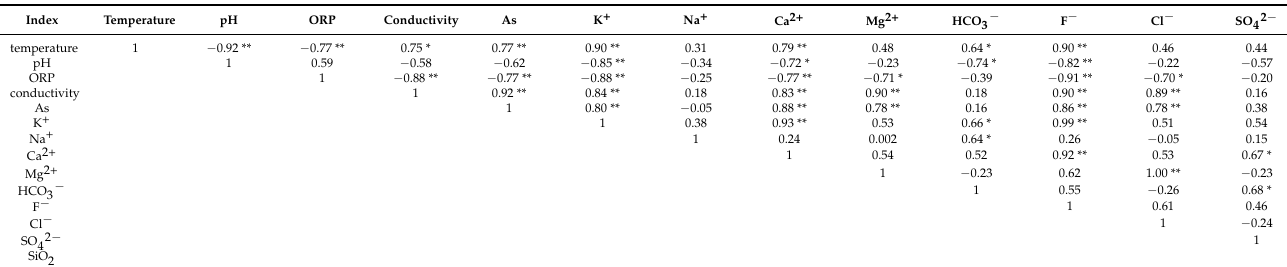
Table 3. Correlation analysis of water parameters.